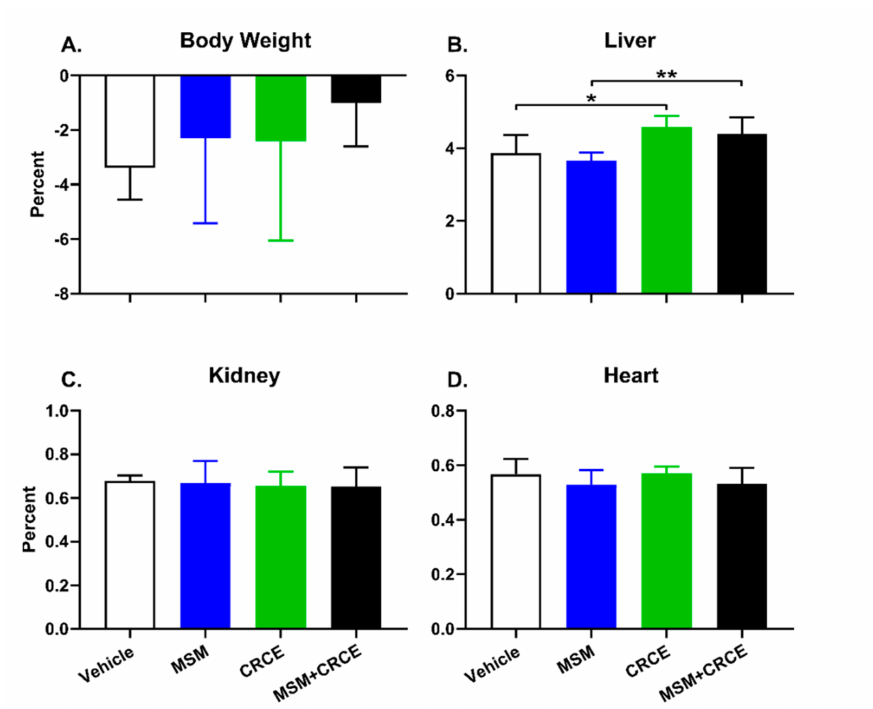
Figure 1. Physiological parameters in response to methylsulfonylmethane (MSM), CRCE, or MSM / CRCE administration in C57BL6 / J mice. ( A ) Body weight change, ( B ) liver-to-body weight, ( C ) kidney-to-body weight, and ( D ) heart-to-body weight ratios. Data are presented as mean ± SD ( n = 6–8). * indicates a significant di ff erence ( p < 0.05), and ** indicates a significant di ff erence ( p < 0.01), as calculated with a two-way ANOVA and Bonferroni post-hoc test. MSM—methylsulfonylmethane, CRCE—cannabidiol-rich cannabis extract.